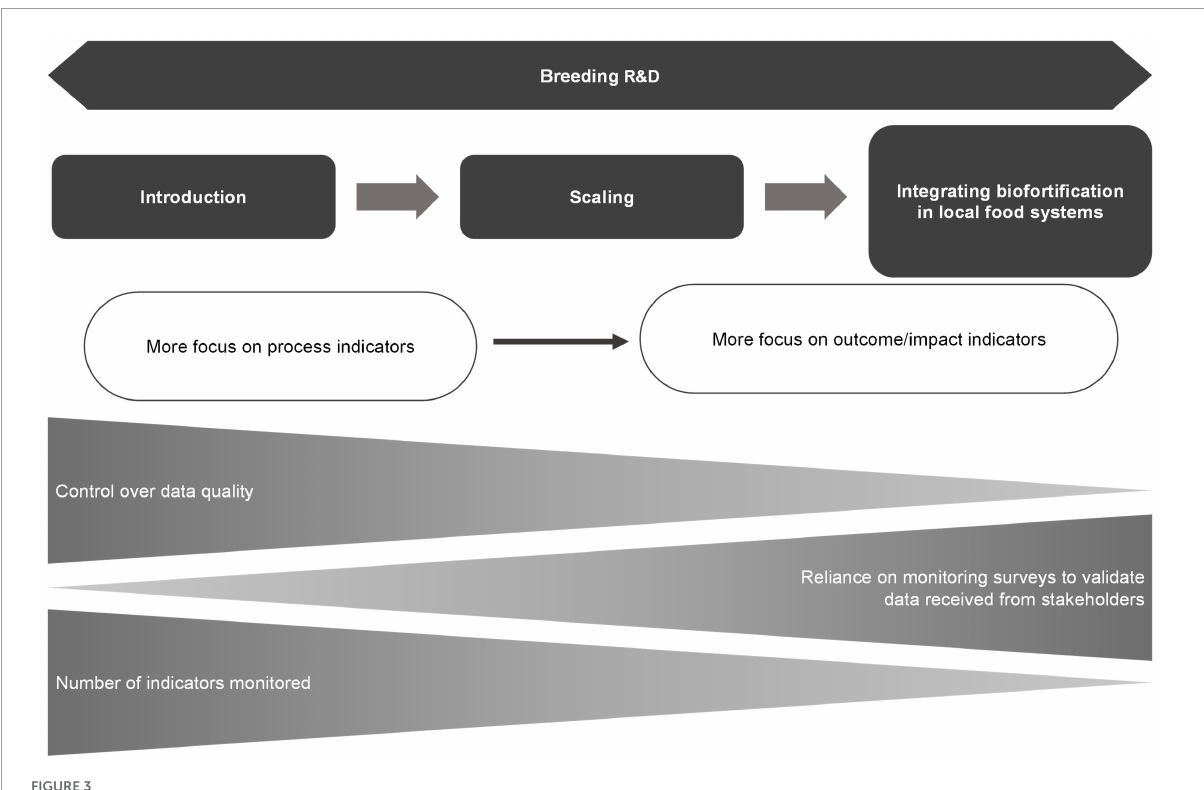
FIGURE3 Evolution of the M&E framework across biofortification implementation